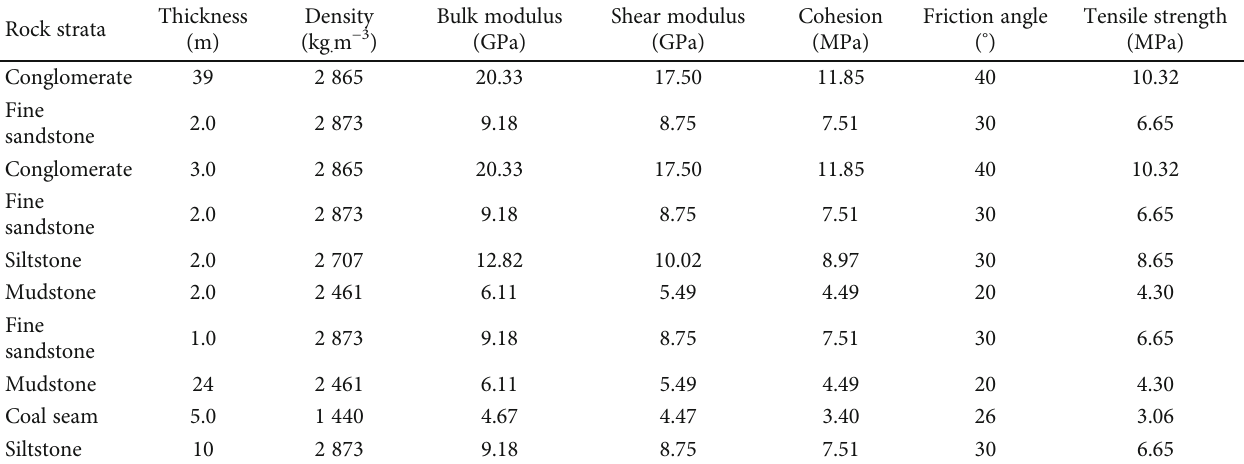
Table 3: Physical and mechanical parameters of rock strata.